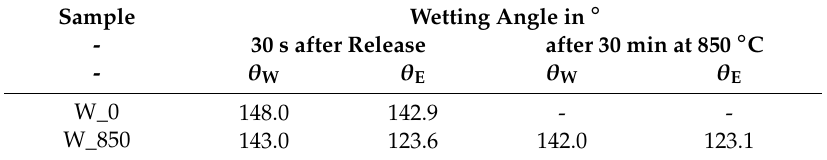
Figure 6. AlSi7Mg0.3 sessile drops on the 316L–40MgO composite substrates: ( a ) W_0 at the point of drop release; ( b ) W_0 after 30 min at 850 ◦ C; ( c ) W_0 after the test; ( d ) W_850 after the drop release; ( e ) W_850 after 30 min at 850 ◦ C; ( f ) W_850 after the test. Table 7. Wetting angles between AlSi7Mg0.3 and the 316L–40MgO composite